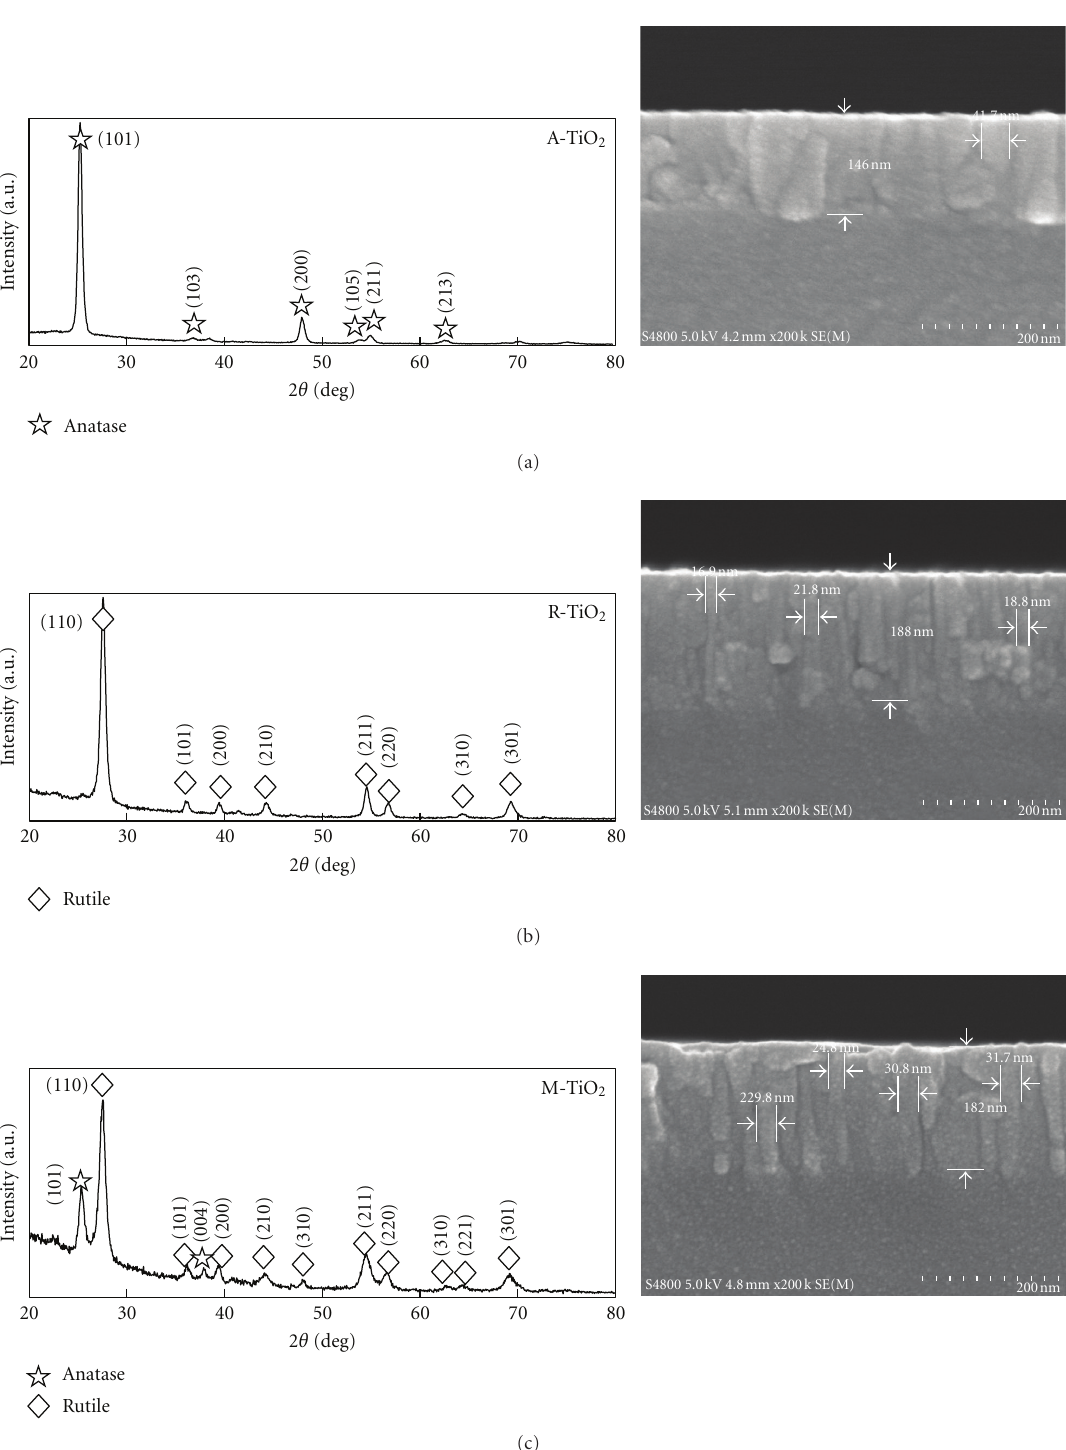
TiO 2 thin film [18] covered only an anatase type, while a few papers reported about N-doped rutile TiO 2 , for example, the paper mentioned di ff erence in the response compared to N- doped anatase TiO 2